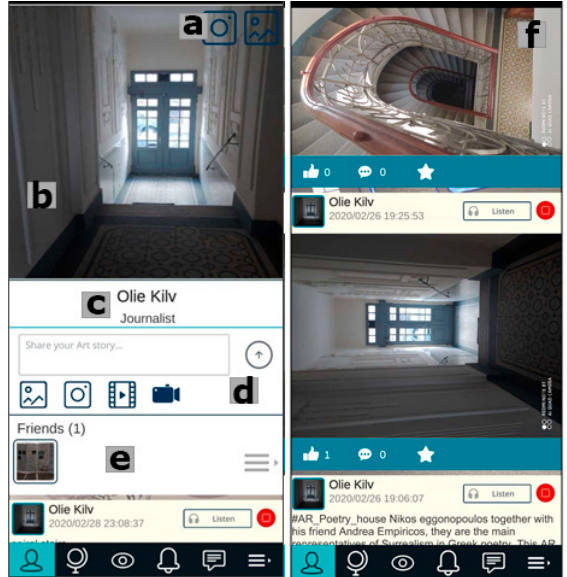
Figure 7. Example screens of a visitor’s user profile and timeline containing the following elements: ( a ) the user’s profile image upload buttons, ( b ) the user’s uploaded profile image, ( c ) the user’s personal info, ( d ) the user’s post input field and selection of its modality buttons, ( e ) the user’s friends list, and ( f ) the user’s post timeline.